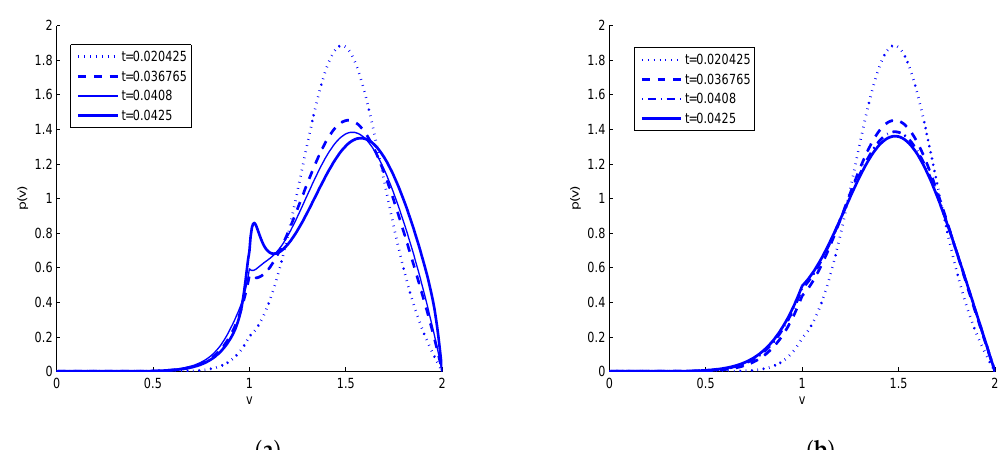
Figure 10. The approximate solution p ( v , t ) using FEM for the initial data given in Equation (20) with v 0 = 1.5 and σ 2 = 0.005 and activity dependence noise a ( N ) = a 0 + a 1 N ( t ) , a 0 , a 1 > 0. Top left: b = 1.2 and a ( N ( t )) = 0.5 + N ( t ) /8. Top-right: b = 1.2 and a ( N ( t )) = 0.4 + N ( t )